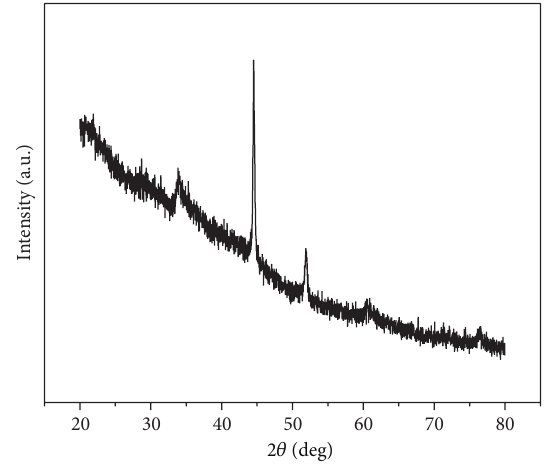
Figure 4: (a) Raney nickel (b), N 13 catalyst, and (c) N 13 spent